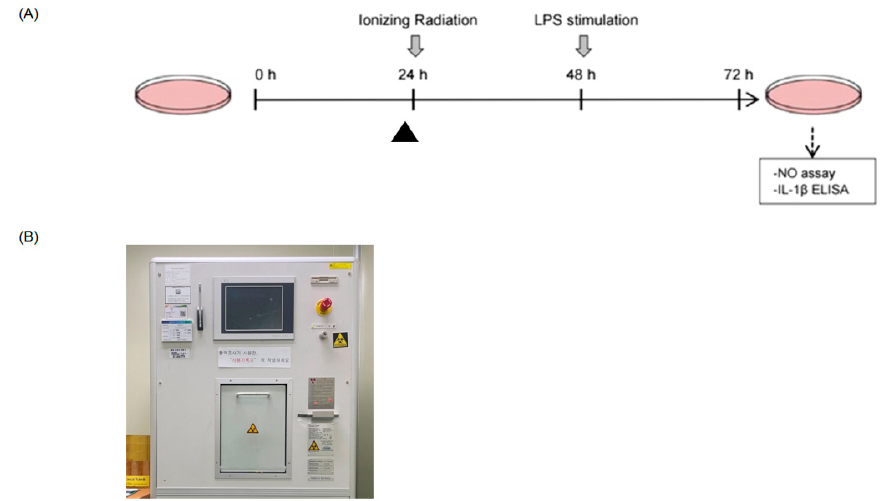
Figure 1. Schematic diagram of the experimental design. ( A ) RAW264.7 macrophages (2 × 10 5 cells/mL) were exposed to 5 Gy of IR and then stimulated with LPS (0.1 µ g/mL) 24 h later. After incubation for another 24 h, the supernatant was recovered to evaluate the IL-1 β and nitrite (NO 2 − ) levels secreted from RAW264.7 cells. The arrowhead ( ▲ ) indicates pretreatment with a signal transduction inhibitor 30 min before irradiation. ( B ) The medical blood irradiator used for cell irradiation.